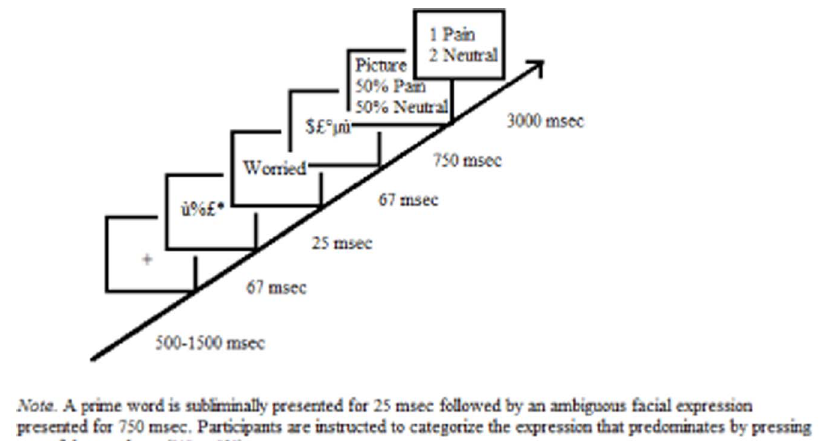
Figure 1. Schematic overview of a typical trial.